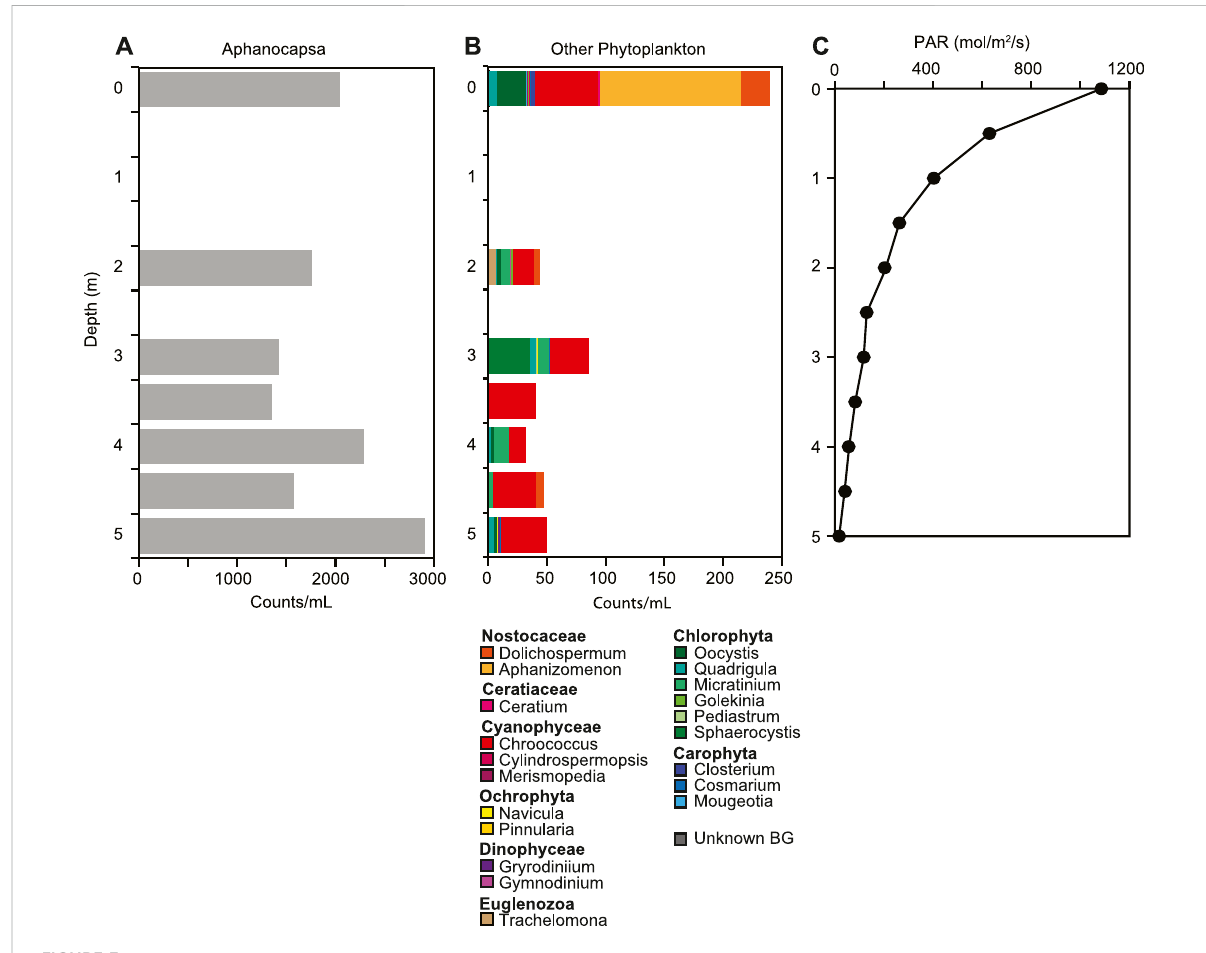
FIGURE 3 Changesinphytoplankton (A,B) and (C) photosyntheticallyactiveradiation(PAR)downthewatercolumn.Aphanocapsawasthemostdominant phytoplankton. Phytoplankton were determined by visual analysis and